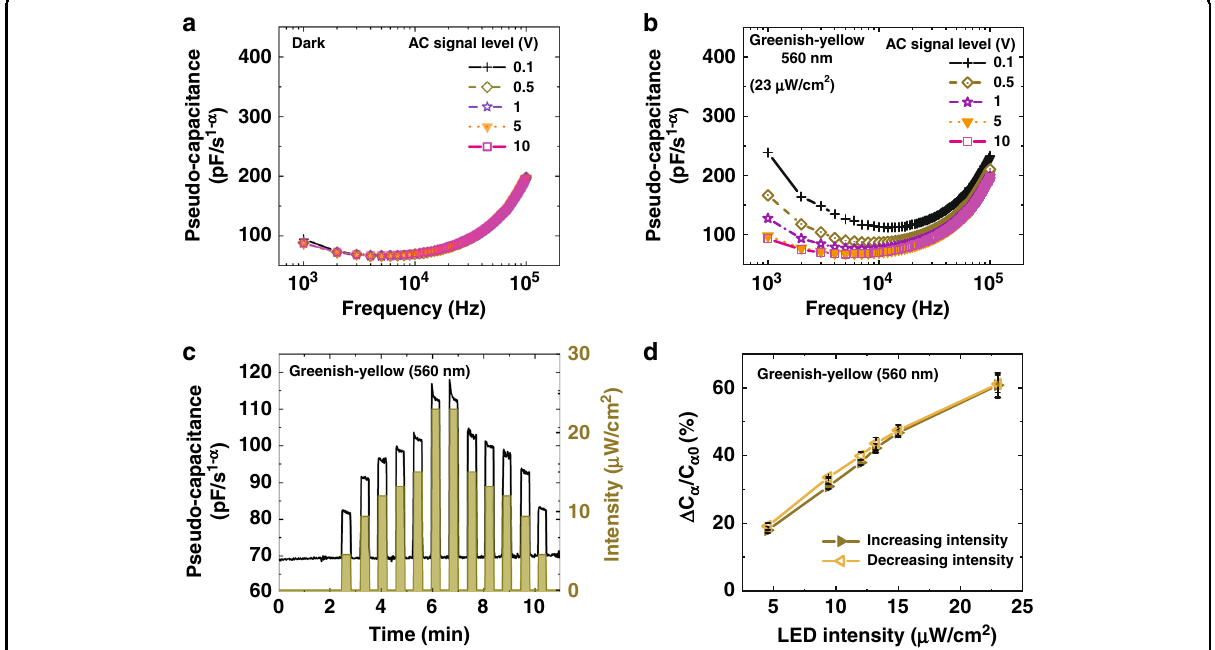
Fig. 6 Mechanism and memory effect study of capacitive photoreceptors (CPRs). The variation in the capacitance due to the AC signal level perturbations to study the effect of the photo-generated carriers in the conductivity modulation of the dielectric a under dark, b under greenish- yellow light. c The transient response of the CPRs (at 10 kHz) with increasing and the subsequent decreasing greenish-yellow light intensities, d the corresponding response of CPRs with the negligible charge accumulation and